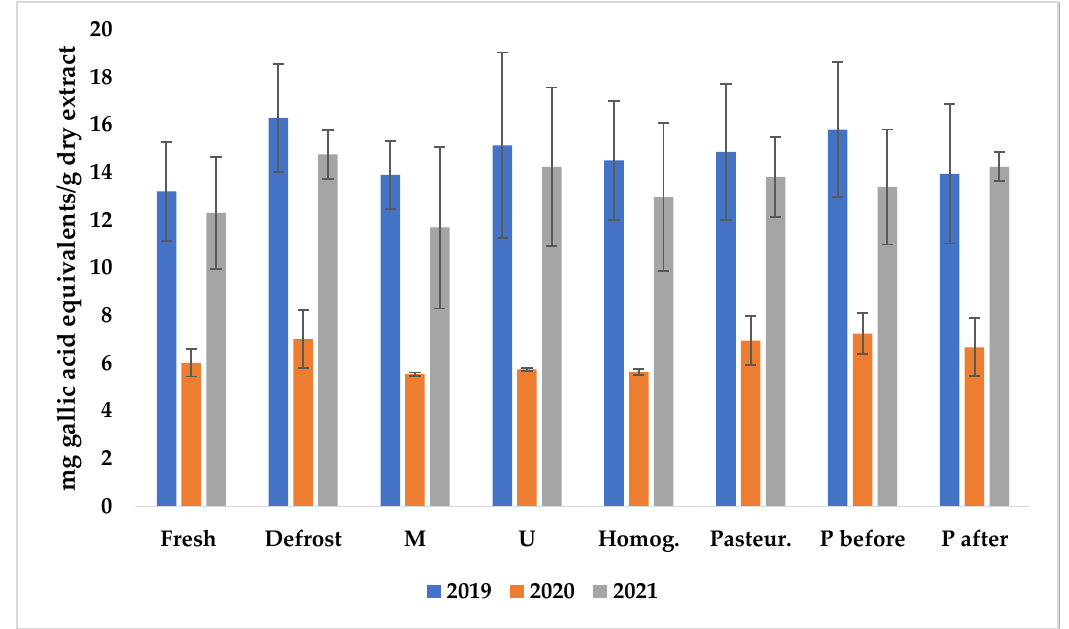
Figure 4. DPPH average values in the three vintages and in the different clusters.